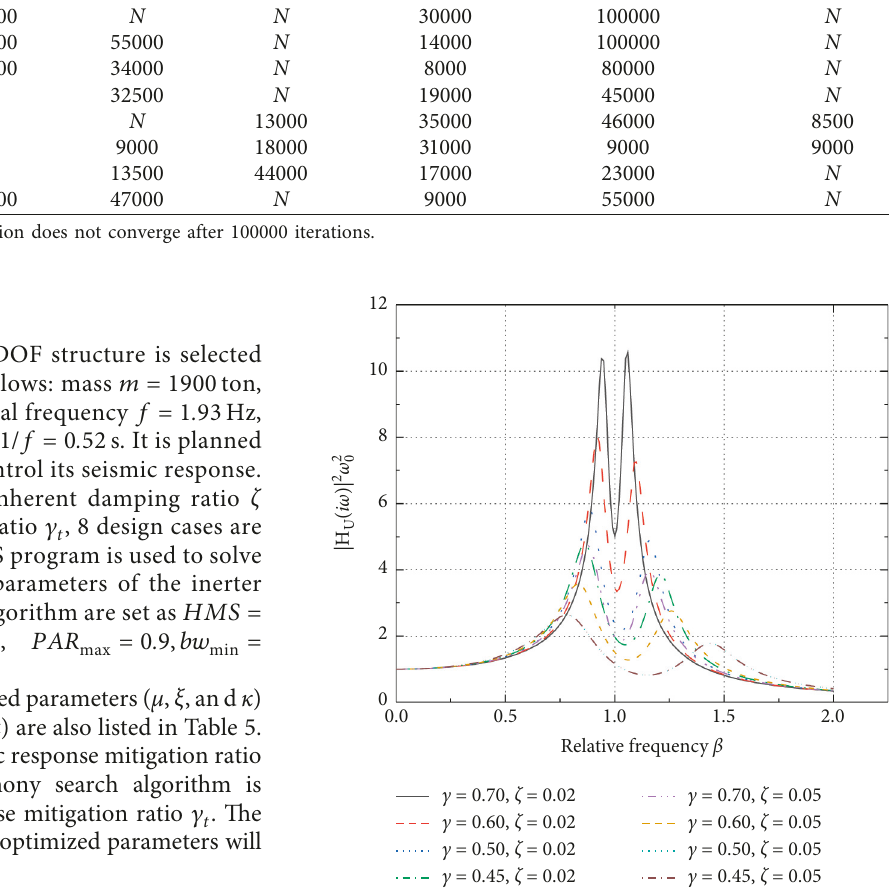
Table 8: Approximate number of iterations for convergency under different penalty weight strategies. Case